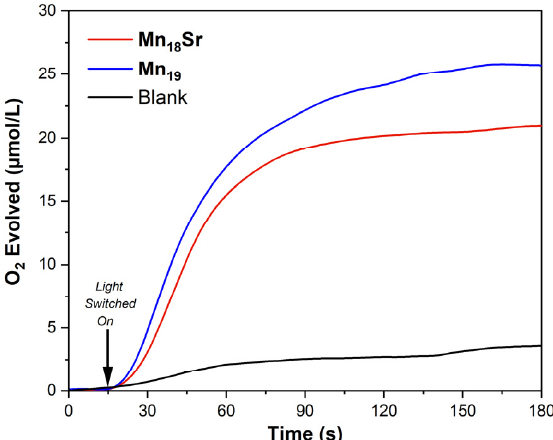
Figure 4. Kinetic monitoring (Clark electrode) of the light-driven O 2 evolution response of Mn 18 Sr (red) and Mn 19 (blue). Conditions: 5 nmol WOC loading in a 10 mM NaP i buffered aqueous solution (5 mL, initial pH = 7) containing Na 2 S 2 O 8 SEA (10 mM) and [Ru(bpy) 2 (deeb)](PF 6 ) 2 PS (2 mg, 2.33 µmol). Irradiated using an LED lamp ( λ = 470, 10 mW cm − 2 ). The mixture was stirred at a constant rate of 500 rpm and maintained at 25 ◦ C by immersing the reaction vessel in a water